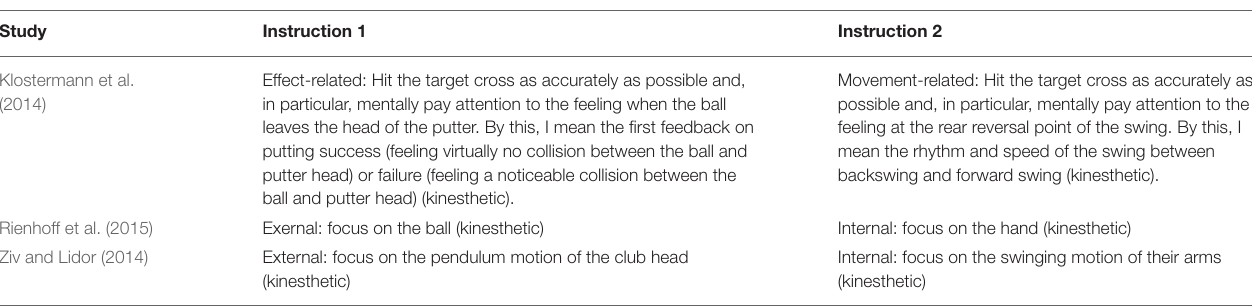
TABLE 1 | Varying used focus of attention instructions in aiming tasks. Study External instruction Internal instruction Supplementary Castaneda and Gray (2007) Participants: less-skilled vs. highly skilled